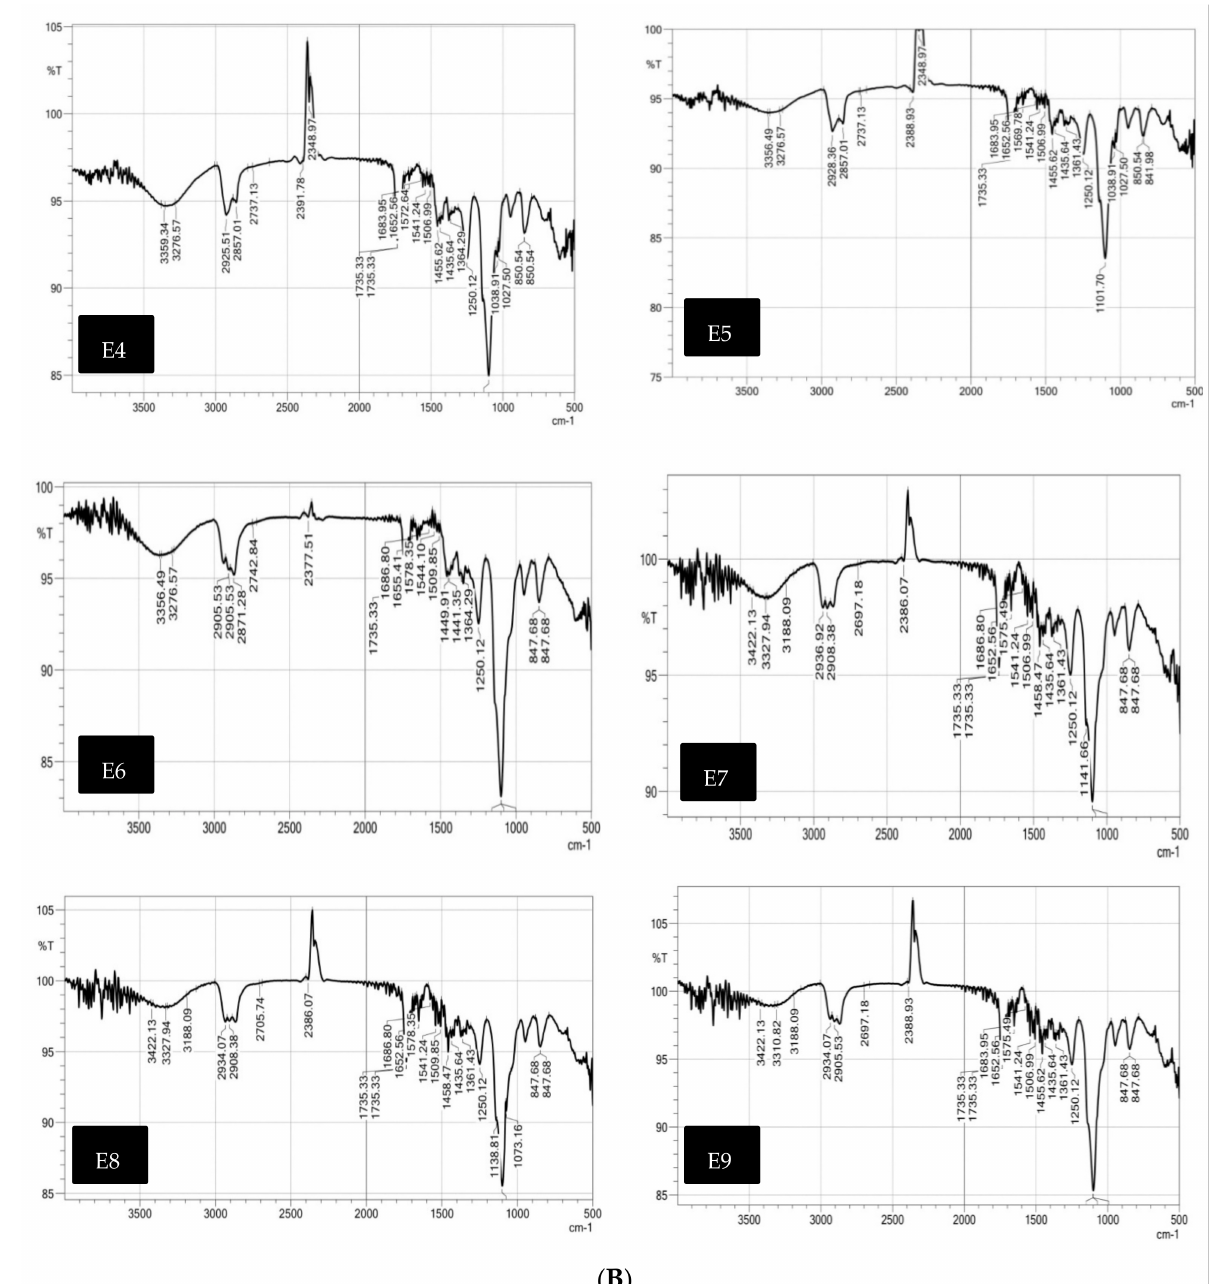
Figure 2. ( A ) DSC thermogram of RLX-NFs formulae (E1–E9) in comparison to that of the pure RLX, PVA, CS, and HPMC, ( B ) IR spectrum of pure (RLX, PVA, HPMC, CS,